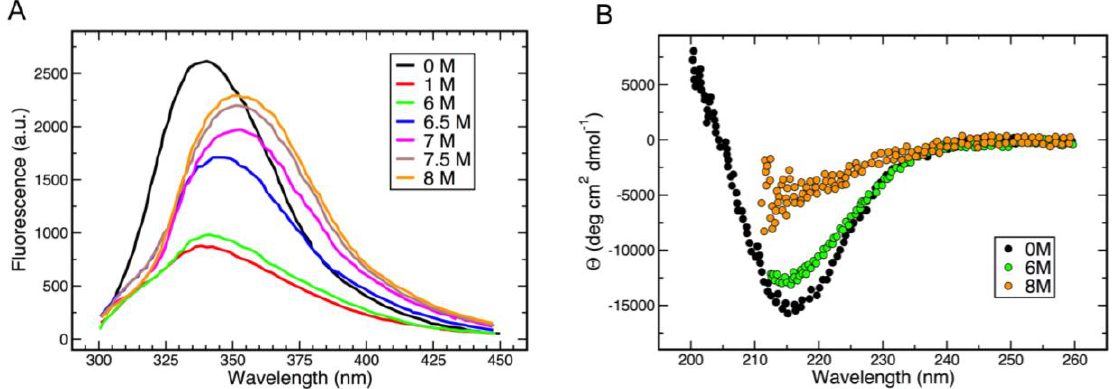
Figure 4. Probing the conformation of gp5 β -BC with guanidinium. ( A ) gp5 β -BC fluorescence in the presence of an increasing concentration of guanidinium; ( B ) gp5 β -BC CD spectra in the presence of 0, 6 and 8 M guanidinium.